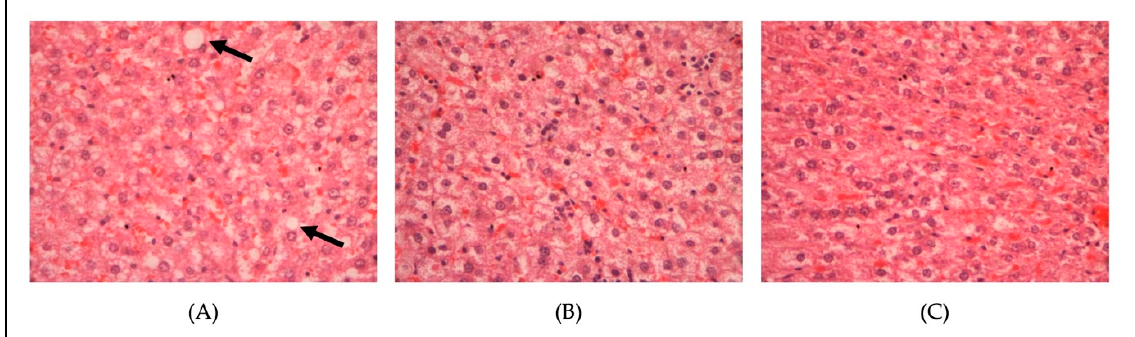
Figure 5. Histopathological changes in the liver of the hypercholesterolemic rats (magnification, ×400). ( A ) Control high-fat diet-fed rats; ( B ) high-fat diet-fed rats treated with fenofibrate (60 mg/kg); ( C ) high fat diet-fed rats treated with linoleic acid (5 mg/kg). The black arrow shows cholesterol deposits within the cytoplasm.